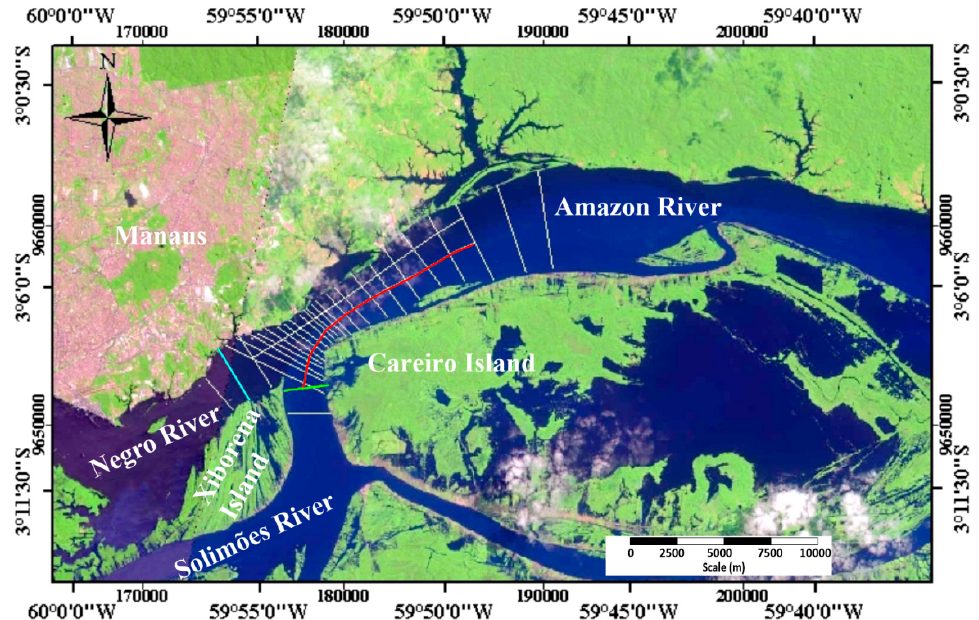
Figure 1. Map of area of the Negro/Solimões confluence. White and coloured solid lines represent transects surveyed with Acoustic Doppler Current Profiler (ADCP) during FS-CNS1 and FS-CNS2 (Long1: red line; N-CNS: blue line; S-CNS: green line). Background: Landsat 8 image. Map datum: WGS84; projection: UTM 21S.